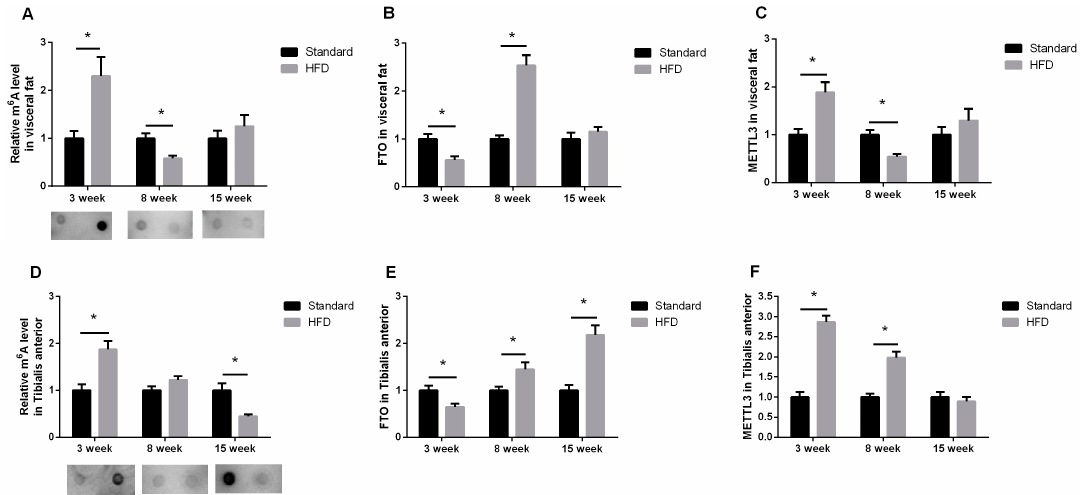
Figure 4. Maternal high-fat intake altered m 6 A methylations and its related genes’ expression in visceral fat and tibialis anterior muscle. ( A – F ) represent the fold changes of the HFD group relative to the control group of the same age (the means of the control groups were set as one at each timepoint). n = 10, * indicates p < 0.05.